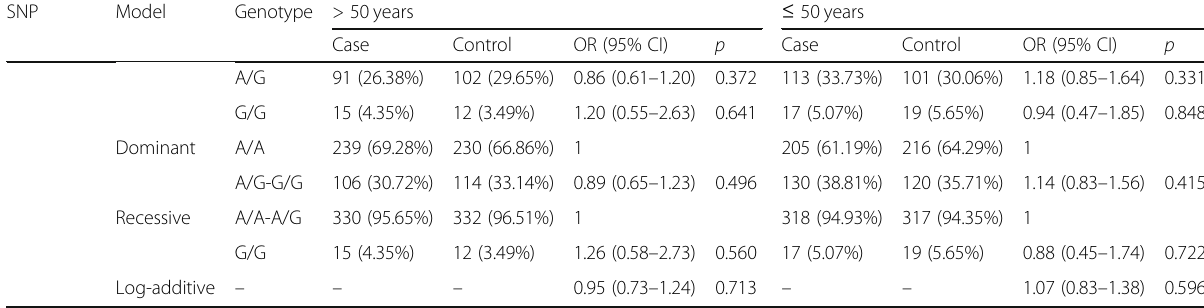
Table 4 The relationship of CASC16 polymorphisms with breast cancer according to the stratification analysis by age (Continued)